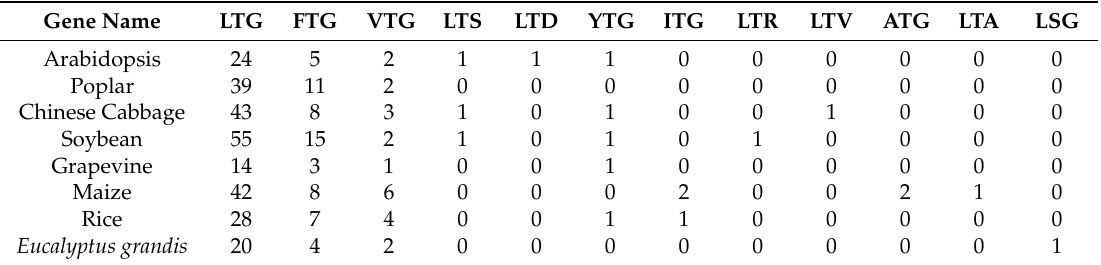
Table 3. The number of structural analysis of conserved motif FxxVQxxxG in E. grandis and other plants.